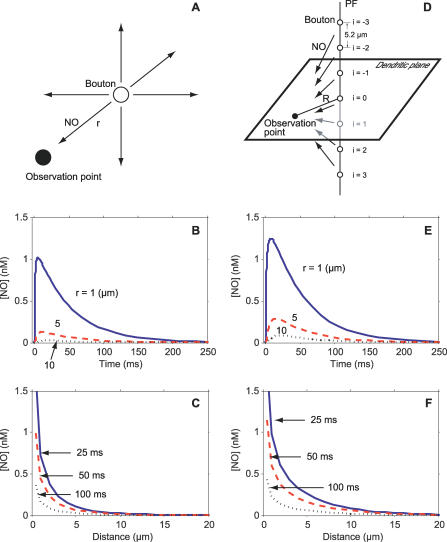
Simulated Concentration of NO Derived from a Single Bouton or from Multiple Boutons on a PF(A–C) NO derived from a single bouton.(A) Activated NOS in a bouton (open circle) produces NO, which diffuses three dimensionally and decays. Only some of the synthesized NO reaches the observation point (closed circle). r, distance between the observation point and the NO-producing bouton.(B) [NO] is plotted against time. The blue solid line, red dashed line, and black dotted line indicate [NO] measured at 1 μm, 5 μm, and 10 μm, respectively, from the bouton.(C) [NO] is plotted against distance. The blue solid line, red dashed line, and black dotted line indicate the concentration at 25 ms, 50 ms, and 100 ms, respectively, from stimulation of the bouton.(D–F) NO derived from boutons along a PF.(D) When a PF fires, NO is released from its boutons (open circles) located at 5.2-μm intervals along the PF and diffuses [23,34]. Thus, [NO] measured at the observation point (closed circle) on the dendritic plane at distance R from the PF is the sum of [NO] from each bouton at distance
μm (i = 0, ±1, ±2,...). Of course, NO diffuses from each bouton in all directions, but only diffusion towards the observation point is indicated (arrows) for clarity.
(E) [NO] is plotted against time. The blue solid line, red dashed line, and black dotted line represent [NO] at 1 μm, 5 μm, and 10 μm, respectively, from the PF.(F) [NO] is plotted against distance from the PF. The blue solid line, red dashed line, and black dotted line indicate the concentration at 25 ms, 50 ms, and 100 ms, respectively, after stimulation of the PF. [NO] at distances smaller than 0.5 μm are not shown in (C) and (F), because the delta function in Equation 1 (Materials and Methods) made the NO concentration near the site of synthesis dependent on the discretization size of r in its numerical solution.